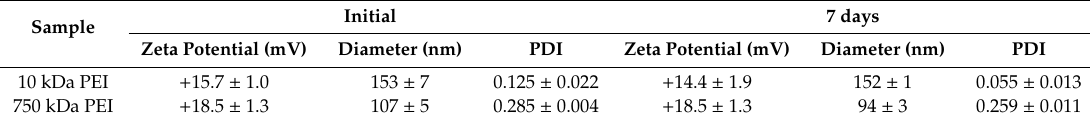
Table 2. E ff ect of polyelectrolyte stabilizer molecular weight on nanoparticle properties and stability. Initial 7 Sample